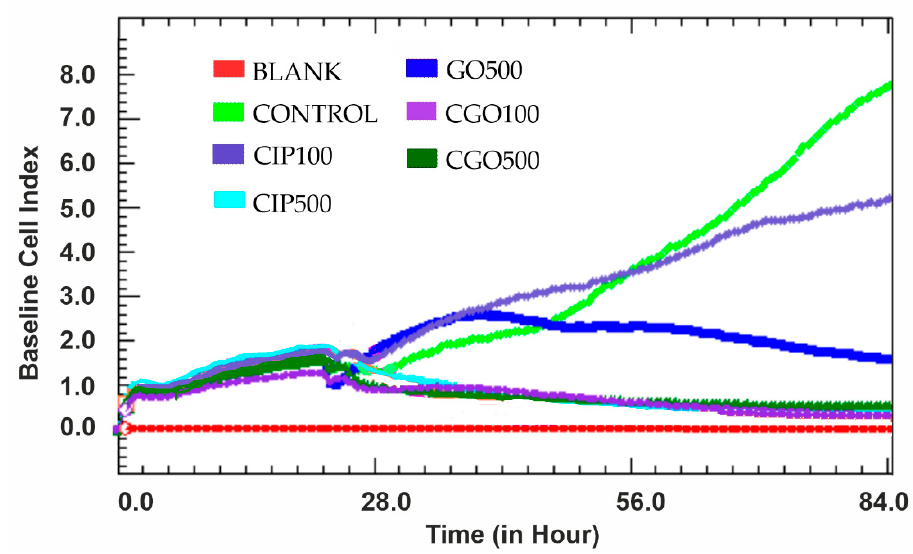
Figure 7. The results of the test performed using the xCELLigence analyzer for the 786-0 line during 84 h with the addition of ciprofloxacin and modified ciprofloxacin in the concentration range 100–500 µ M. The statistical analysis was made with sampled data from specific time points. The cell index parameter is proportional to the amount of cells currently adherent to the e-plate and was measured via impedance compared to